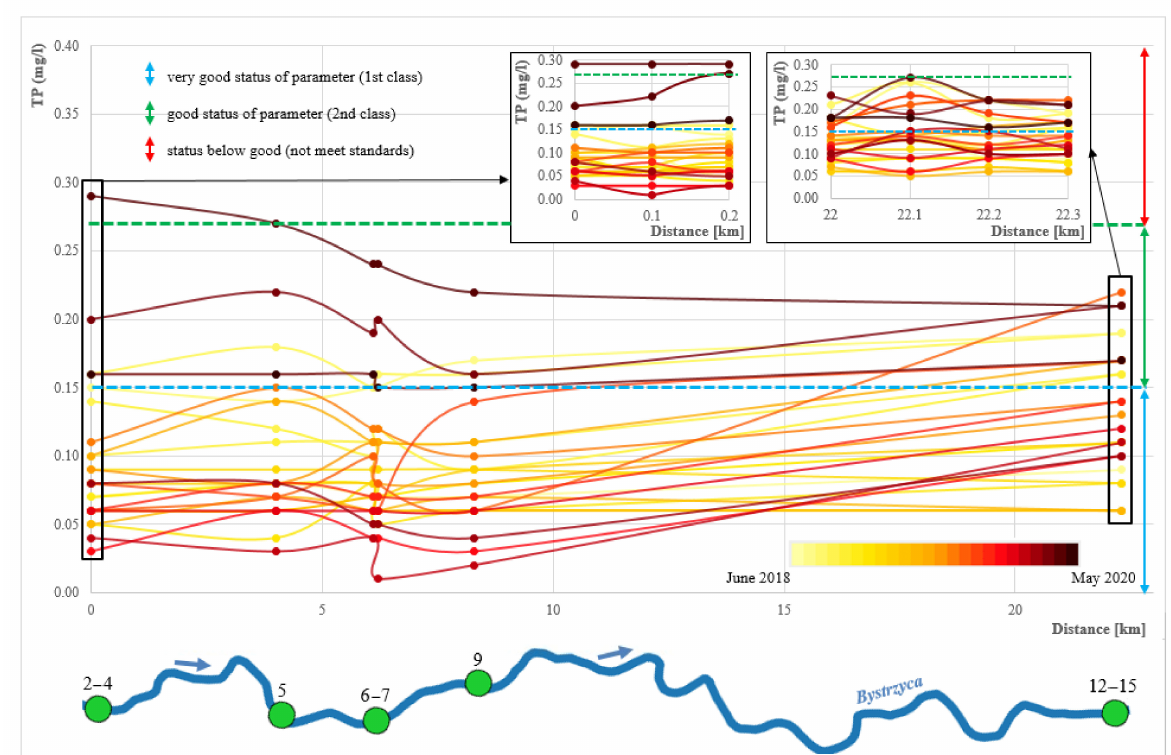
Figure A5. Temporal and spatial variability of TP at the tested measurement points, including the physicochemical condition of the parameter and statistical significance within the Sadowice, Skałka, and Marszowice HPs ( p <